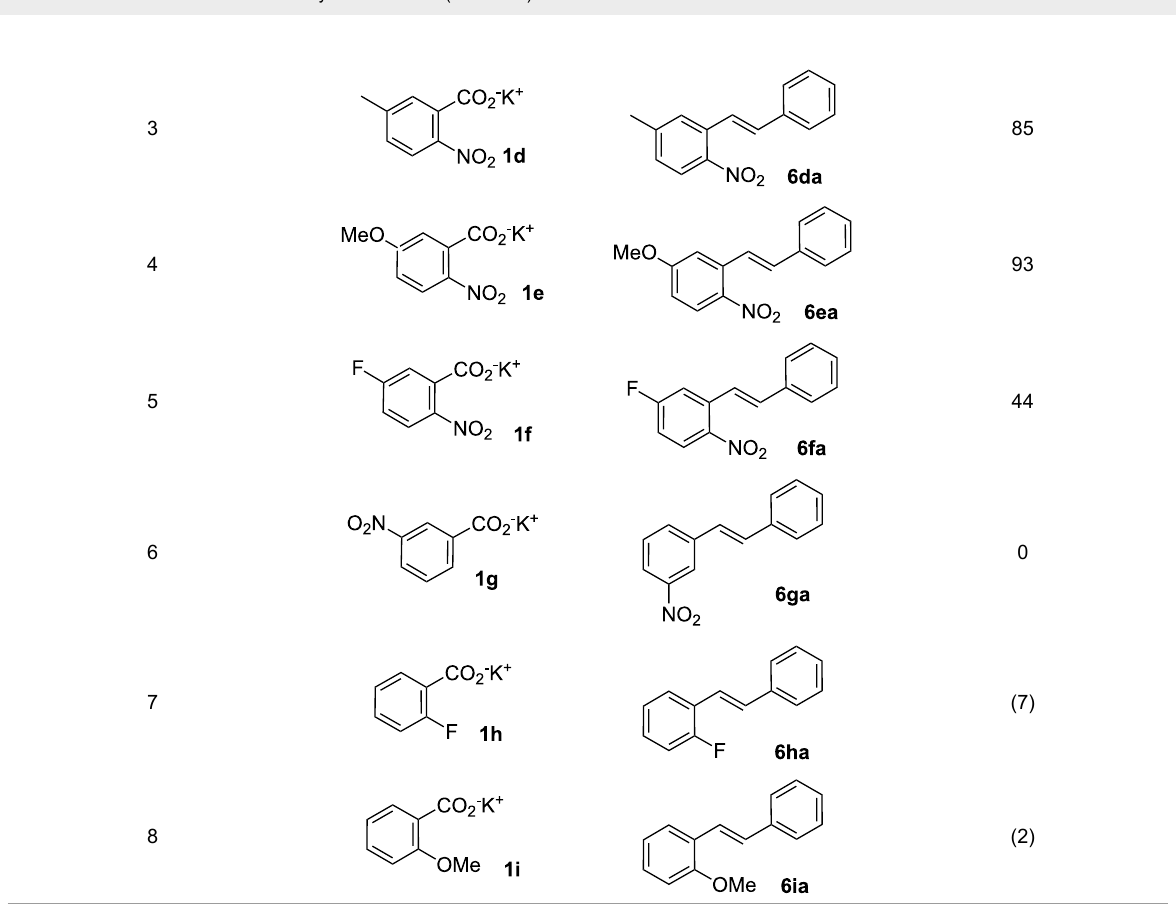
Table 3: Variation of the benzoic carboxylate derivative.